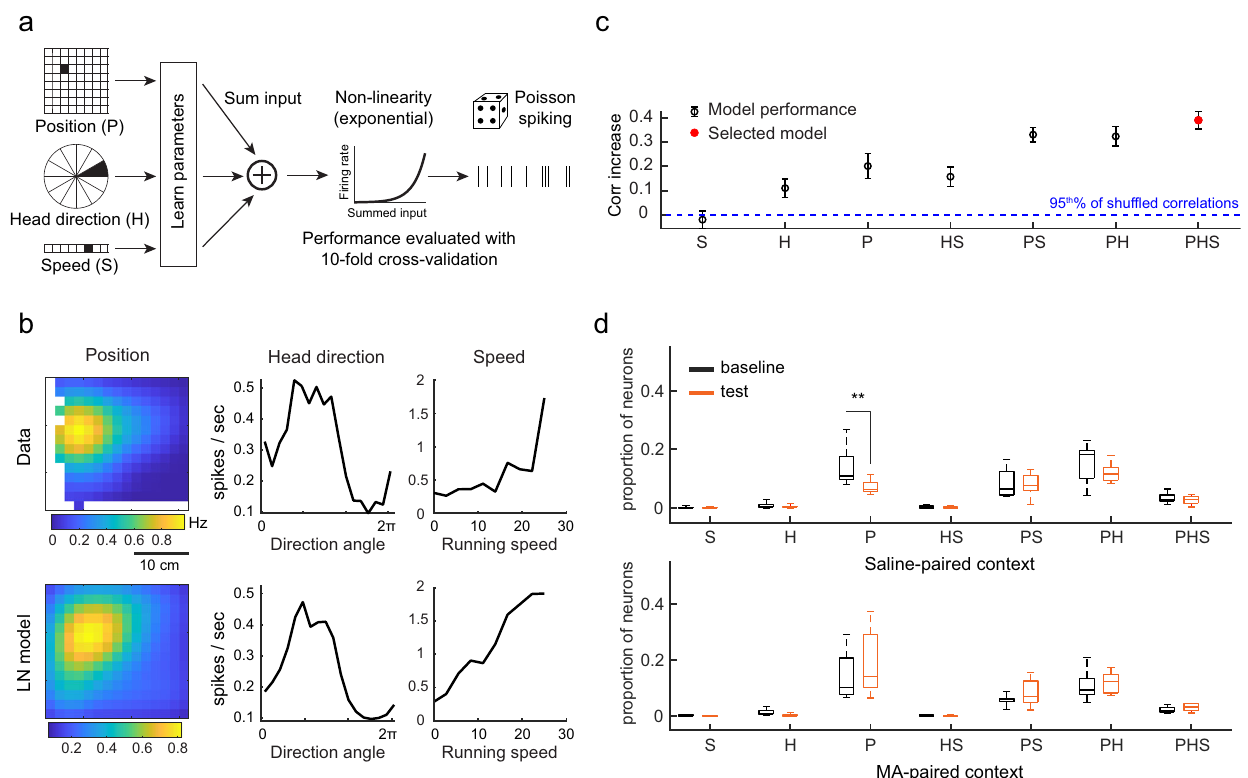
Fig. 6 | Drug-context associations primarily affect place cells that are exclu- sivelytunedtoallocentricposition.a Schematicoflinear-non-linearPoisson(LN) modelframework.Prepresentsposition,Hrepresentsheaddirection,Srepresents speed. b Calcium event rate tuning curves (top) and model-derived response pro fi les from an example PHS cell. c Example of model performance across all modelsfortheexample neuronin ( b )(mean±SEM,correlationincreaserelativeto the95th%oftheshuf fl edcorrelation, n =10crossvalidations).Theselected model